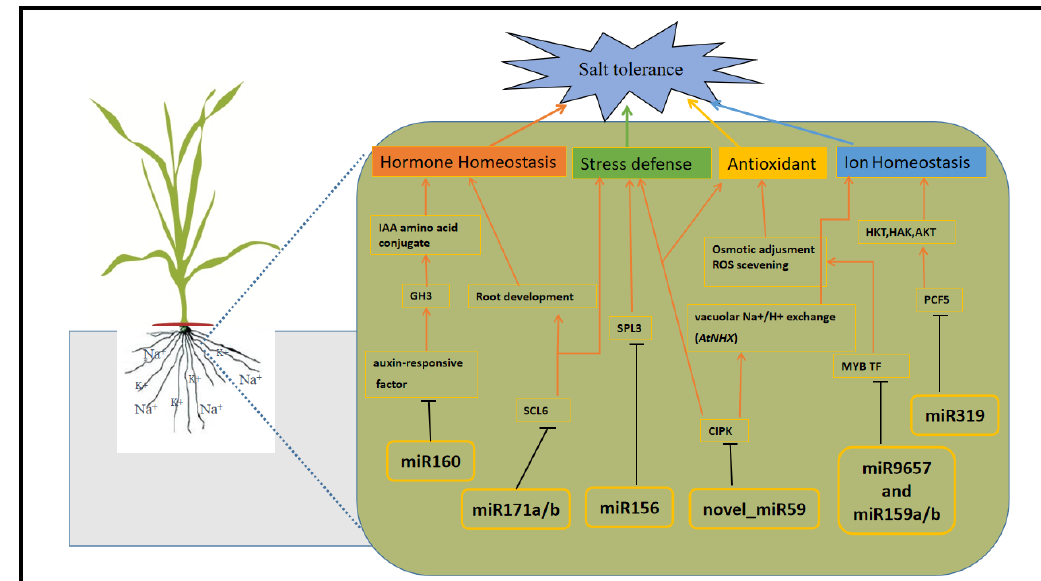
Figure 8. A model representing NaCl tolerance in Suntop. All miRNAs are either unchanged or down-regulated in Suntop. ARF3 (Auxin responsive factor 3), CIPK (CBL-interacting protein kinases), IAA (Indole-acetic acid), GH3 (GRETCHEN HAGEN 3), PCF5 (Proliferating cell factors), SCL6 (Scarecrow-like protein 6), SPL3 (Squamosa promoter binding like protein 6).